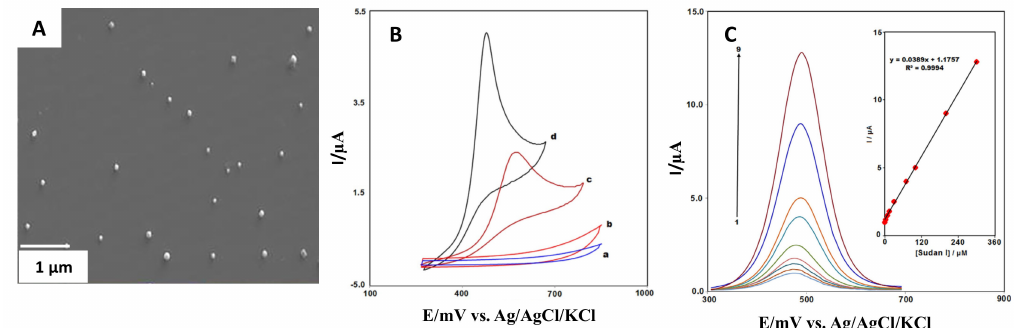
Figure 12. ( A ) La 3+ -doped Co 3 O 4 nanocubes SEM micrograph. ( B ) Cyclic voltammograms obtained for the bare (a, c) and modified (b, d) SPE in presence and absence of Sudan I dye. ( C ) Differential pulse voltammograms of La 3+ -doped Co 3 O 4 nanocubes/SPE for different Sudan I concentrations (0.3–300 µ M). Reproduced with permission of Mahmoudi-Moghaddam et al., Food Chemistry Journal; published by Elsevier, 2019 [49].